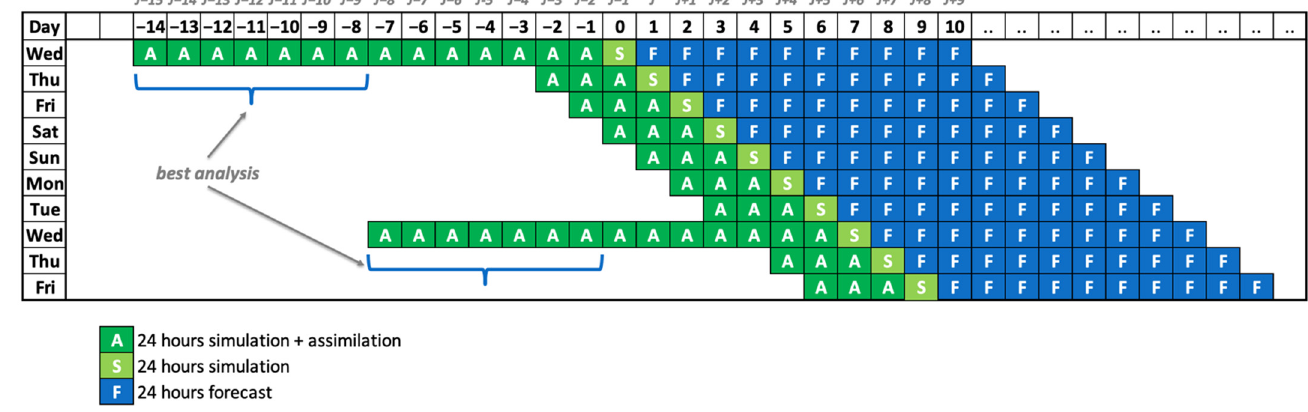
Figure 2. BSFS processing chain.